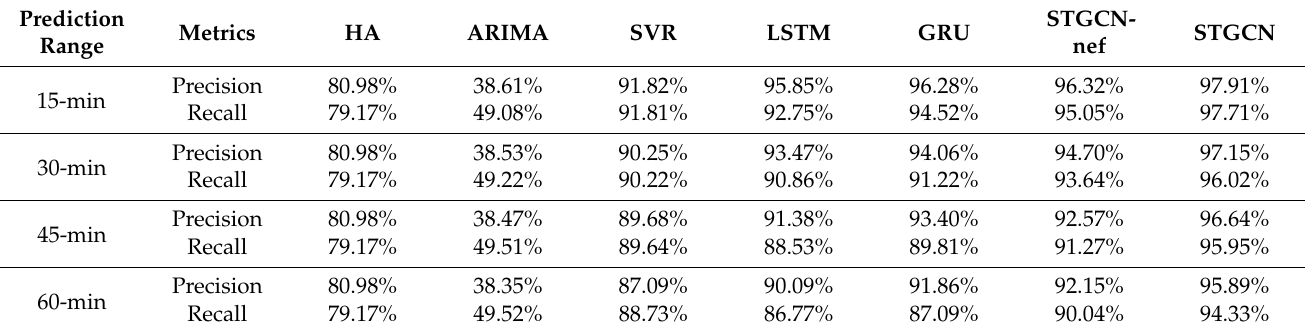
Table 4. Comparing the classification performance of different models on the dataset of air traffic situations in 30 Shanghai control